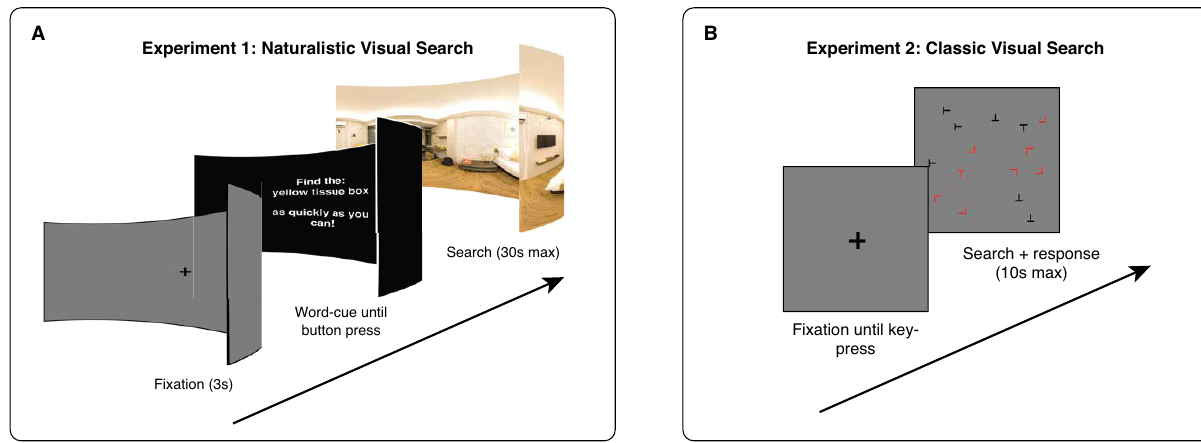
Figure 2. Experimental paradigms. ( A ) Naturalistic visual search paradigm. After a pre-trial fixation, participants were presented with a conjunctive word description of a target object. Subsequently, participants actively searched (e.g., head-turns, saccades, etc.) for the described object inside an immersive photosphere. ( B ) Classic visual search paradigm. After a pre-trial fixation, participants searched for a red T within a cluttered array shown via a head-fixed